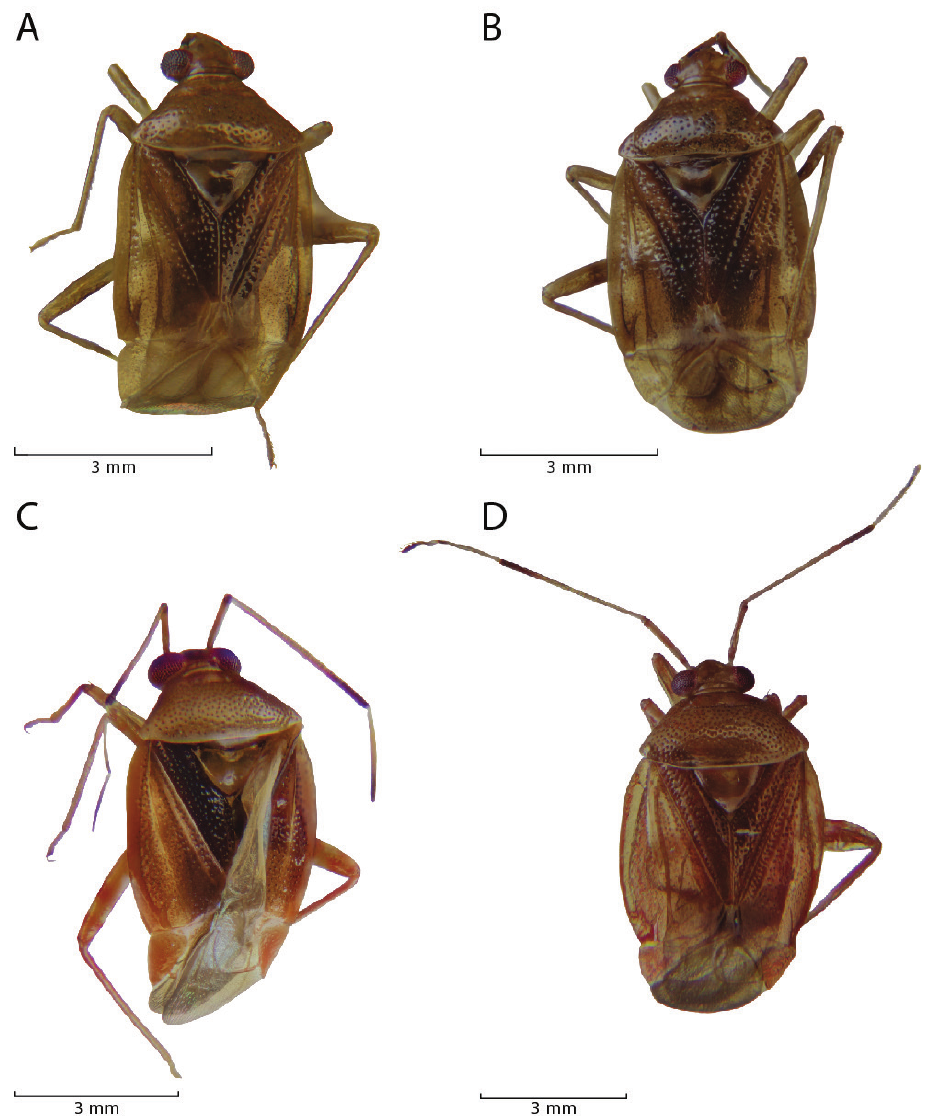
Figure 2. Dorsal habitus images of Philicoris mayon sp. n. ( A male OMNH 66500; B female OMNH 66501) and Philicoris palali sp. n. ( C male OMNH 7804; D female OMNH 7805). light yellowish brown with orange tinge, orange tinge most predominant along em- boliar margins and cuneus, clavus darker orange-brown to dark brown, corium darker yellowish brown, membrane pale brown with orange veins. Abdomen: orange-brown. Surface and vestiture: Head : smooth and shiny, clothed with dense simple setae, an- tennal segments covered with simple setae of uniform length. Thorax: collar and calli smooth, remaining surface of pronotum punctate, covered with dense simple